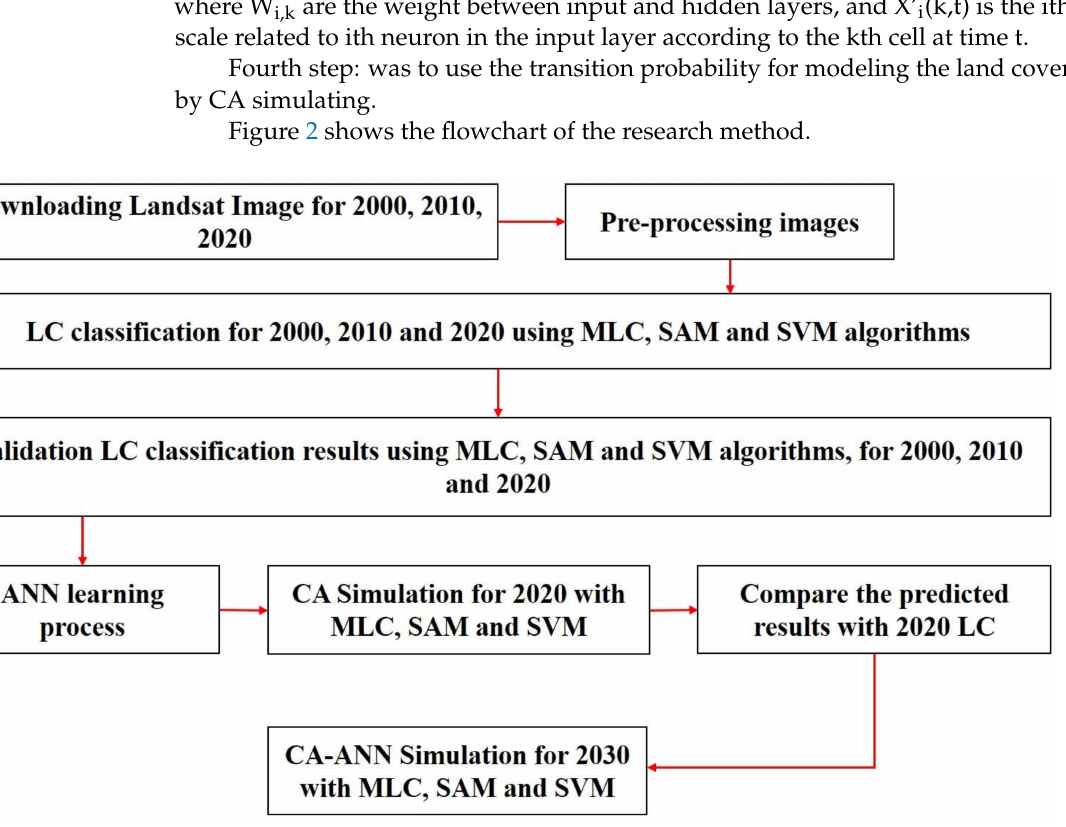
Figure 2. Flowchart of the